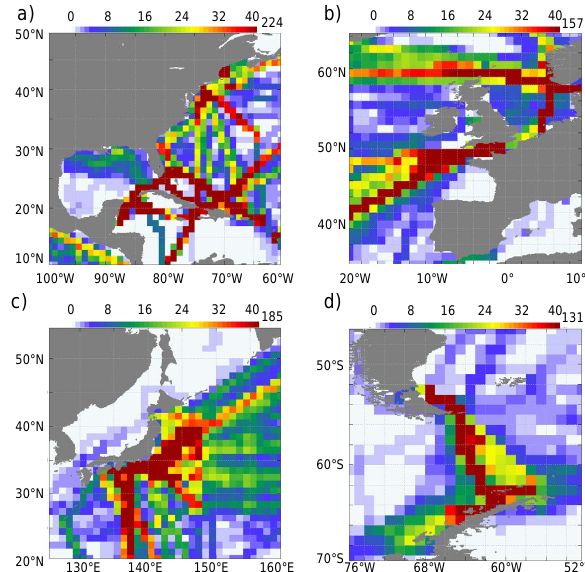
Figure 9. Number of data sets (colour bar on top of subplots) with surface water f CO 2 measurements per 1 ◦ latitude by 1 ◦ longitude grid cell for 2000 to 2009 for (a) the northwest Atlantic Ocean and the Caribbean Sea, (b) the northeast Atlantic Ocean and European shelf seas, (c) the northwest Pacific Ocean and (d) Drake Passage in the Southern Ocean. The presence of repeated f CO 2 observations made on ships of opportunity and research supply ships is clearly visible in coastal seas and the open